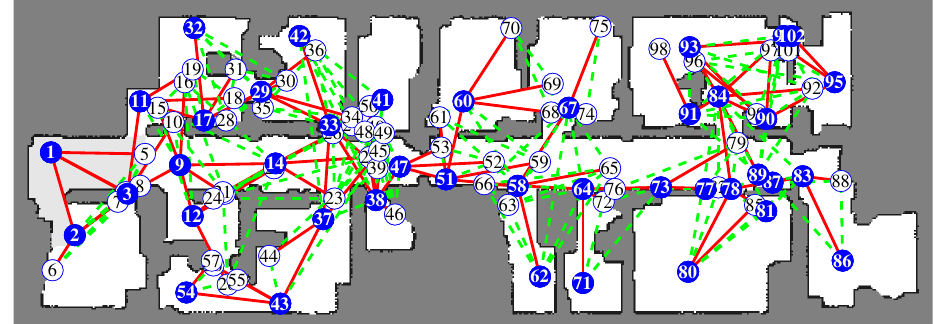
Figure 9. Frontier-graph structure on the final grid map obtained from BFS exploration. The numbers indicate the ID of each frontier node. Red lines are edges between the parent and child nodes. Dotted green lines are edges between sibling nodes. Blue circles are active nodes, and white circles are inactive